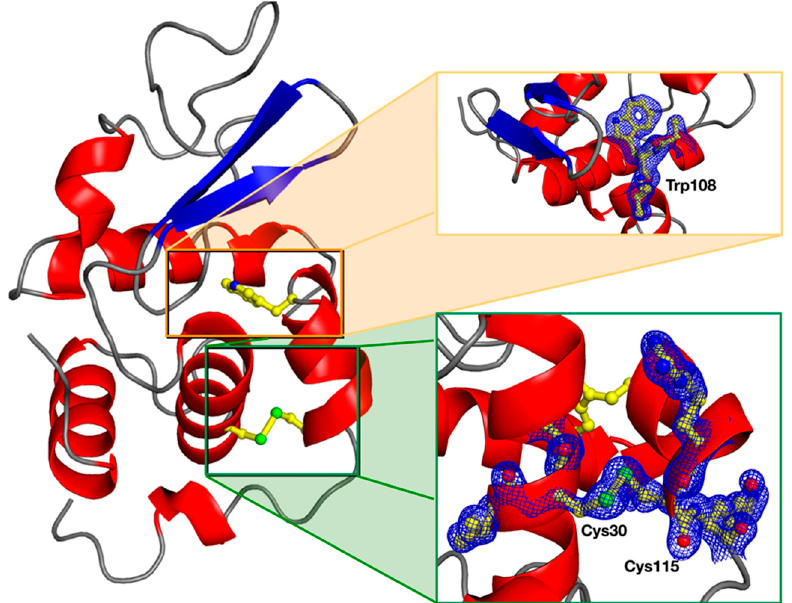
Figure 5. Overall structure of the Lysozyme refined at 1.83 Å resolution. The quality of the data can be seen in the two insets, showing the electron density around Trp108 and the disulfide bridge Cys30-Cys115.